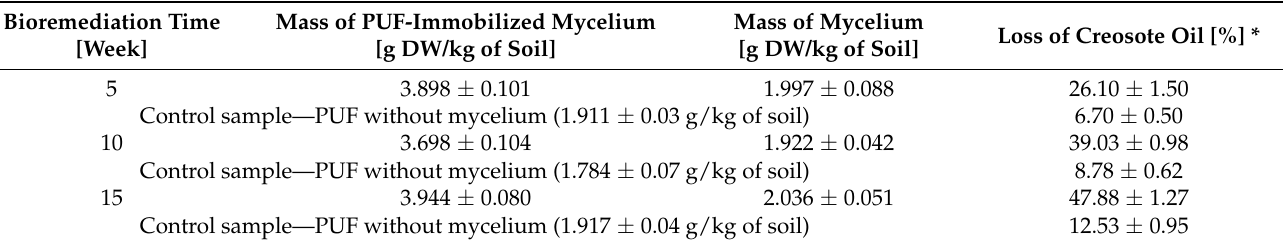
Table 1. Weight loss of creosote oil during 15-week bioremediation of soil by PUF-immobilized mycelium of B. adusta DSM 3375.